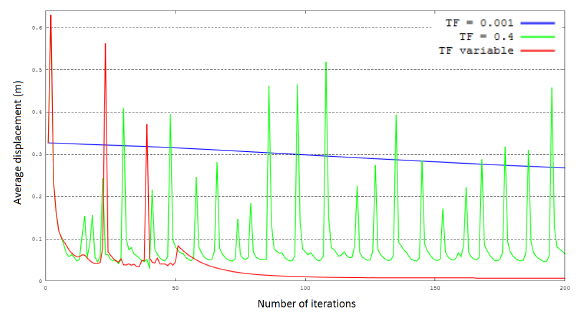
Figure 9: Number of iterations vs average correction (m) for dif- ferent reducing factors : 0.4 (green), 0.001 (blue) and variable